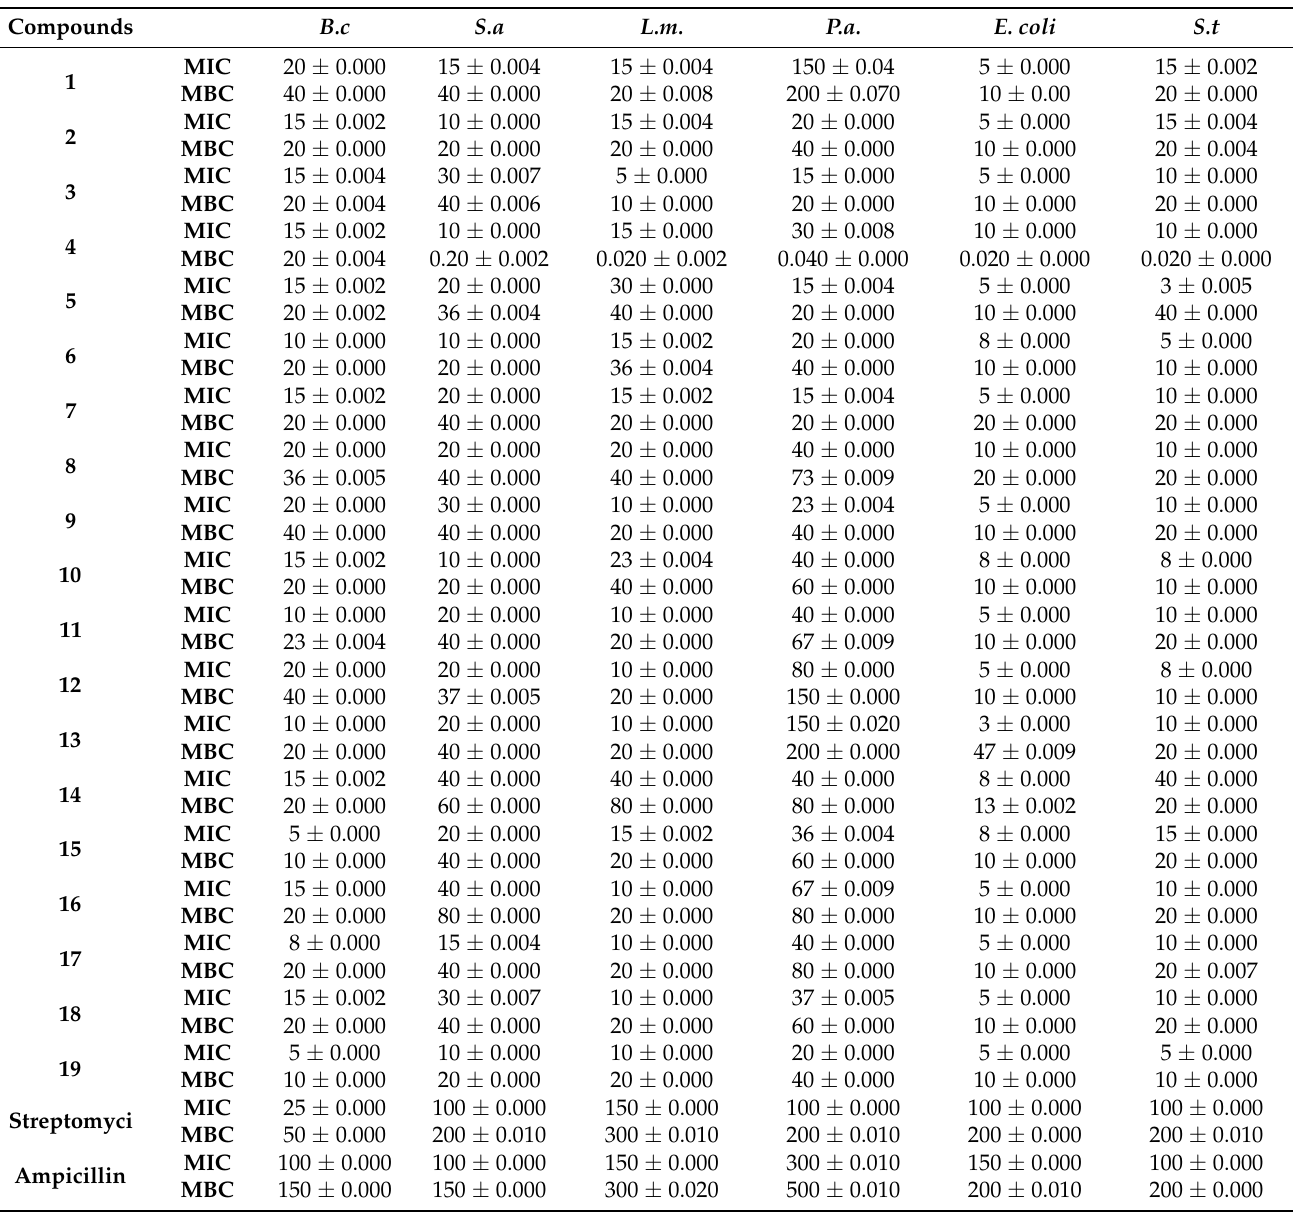
Table 2. Antibacterial activity of compounds 1 – 19 (MIC and MBC in µ